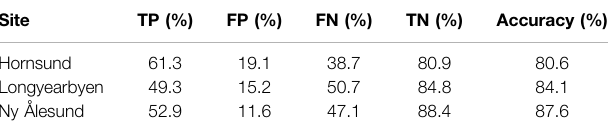
TABLE 2 | Accuracy metrics used to evaluate the SAR ROS detections at Hornsund, Longyearbyen and Ny Ålesund for 7 winter seasons, beginning 2013/2014. Metrics evaluated are the true positive (TP) rate, false positive (FP) rate, false negative (FN) rate and true negative (TN) rate, each of which are used to calculate the overall detection accuracy based on Eq. 3